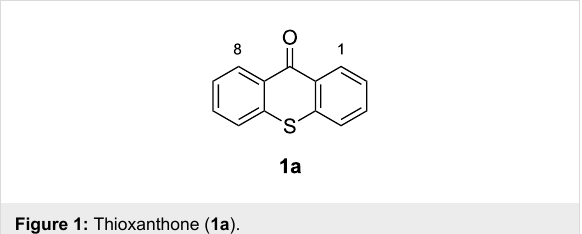
Figure 1: Thioxanthone ( 1a